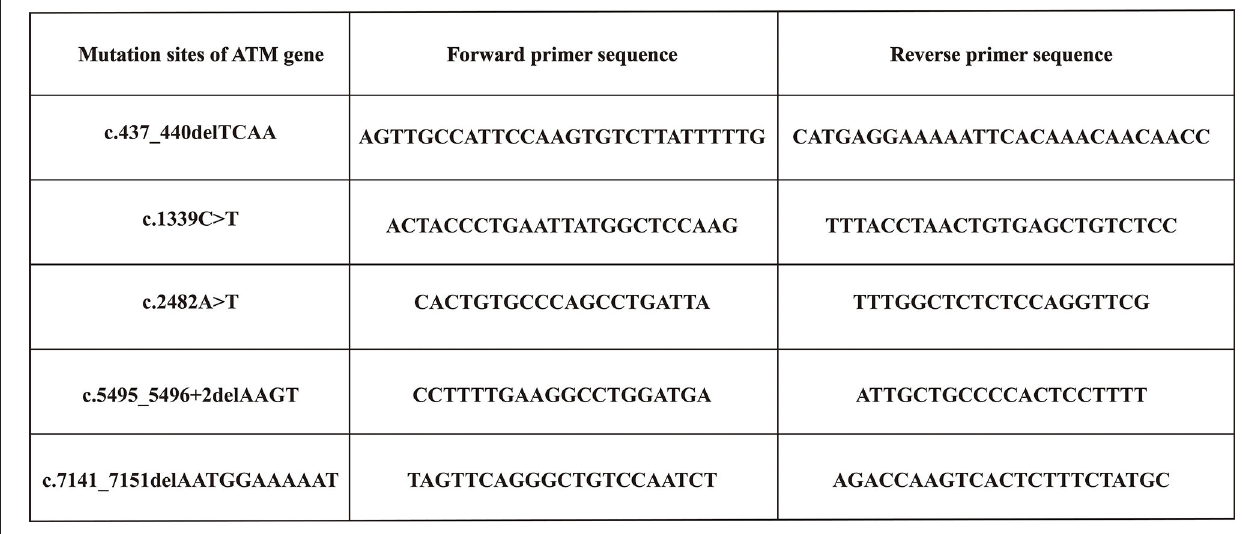
FIGURE 1 | Primers sequences used to amplify the mutation sites of ATM